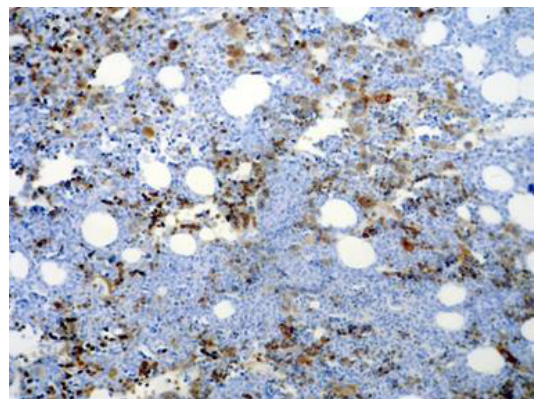
Fig 2. α-synuclein staining in AML-M7; erythroid precursors and all of the abnormal megakaryocytes are positive, while myeloblasts in the background are negative (x100).